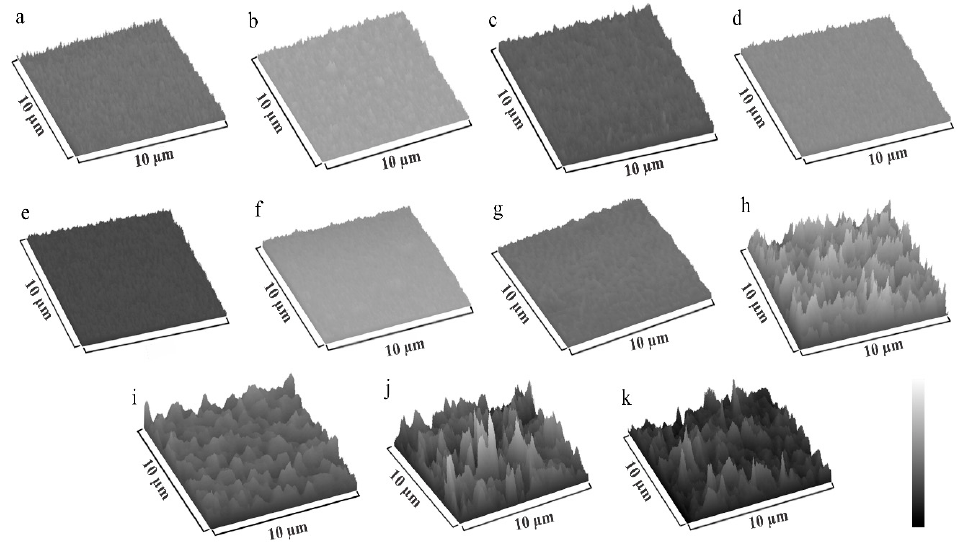
Figure 7. GDOES depth profiles of: ( a ) Ag:HAp-PDMS; ( b ) Zn:HAp-PDMS; ( c ) HAp-PDMS composite layers.